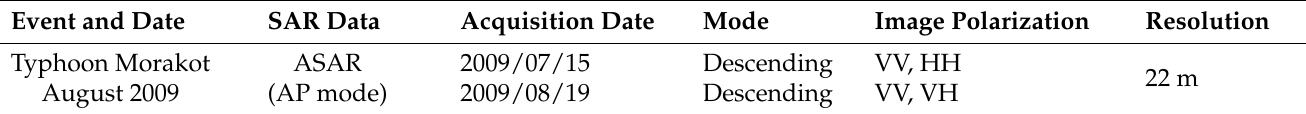
Table 1. Specifications of SAR image used for detection. ASAR—Advanced SAR.